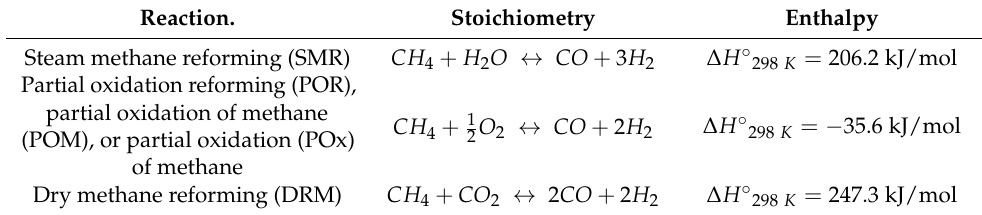
Table 20. Main reactions involved in the catalytic reduction of methane with CO 2 .